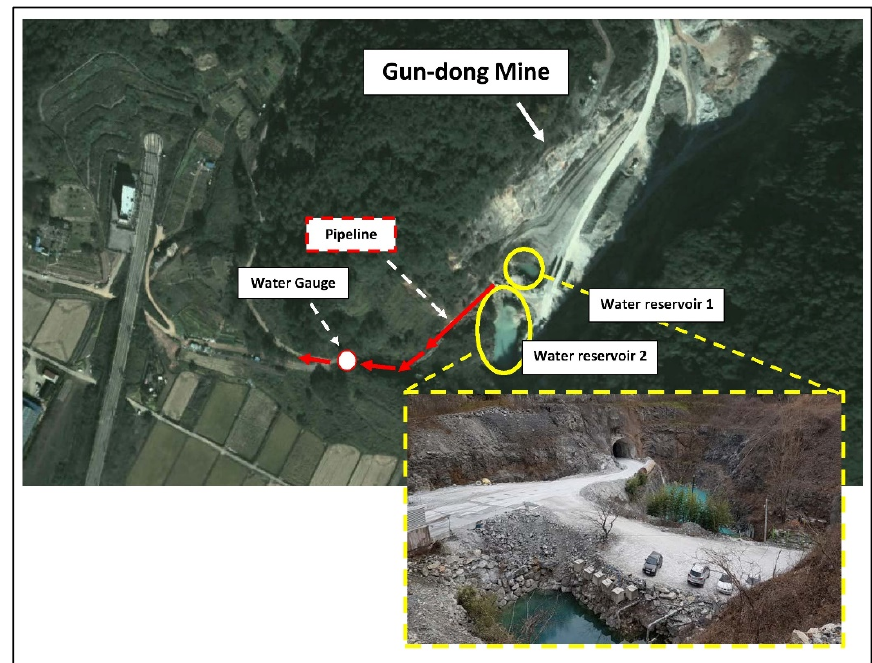
Figure 29. Drainage system of the Gun-dong mine.